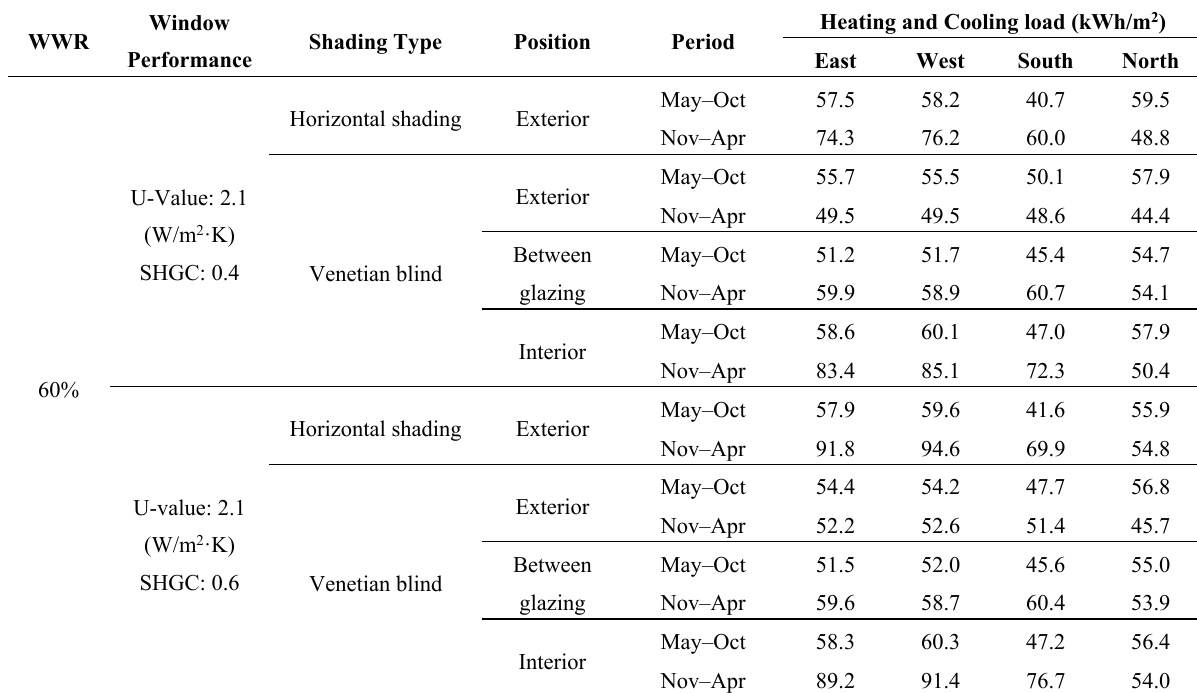
Figure 9. Type of shading and venetian blinds. Table 6. Heating and cooling load variation with horizontal shading and venetian